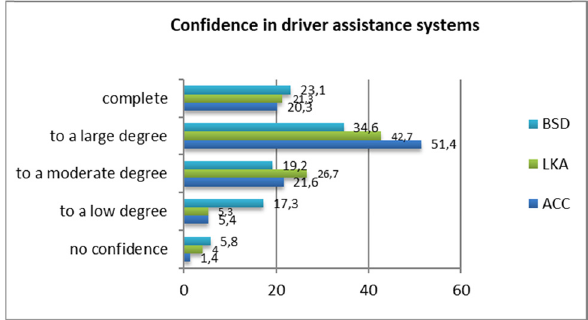
Figure 4: Con fi dence in driver - assistance systems ( % ) . Source: author ’ s own